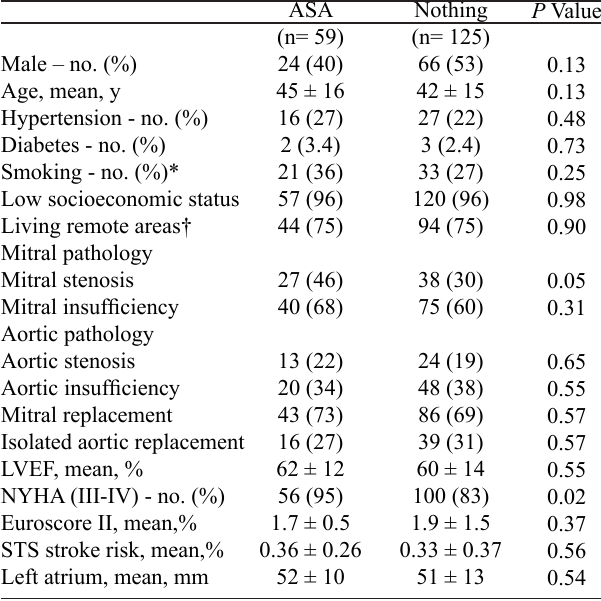
Table 1. Characteristics of patients at baseline (n =